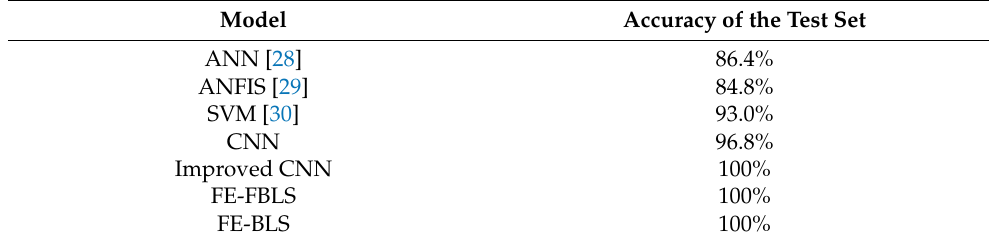
Table 4. Comparison of classification accuracy of each classification model.